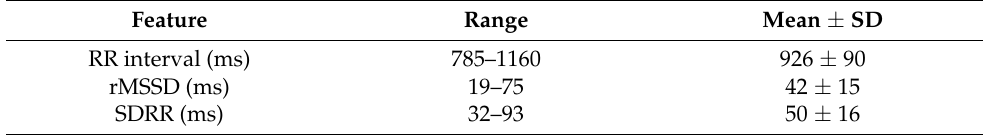
Table 2. HRV Reference